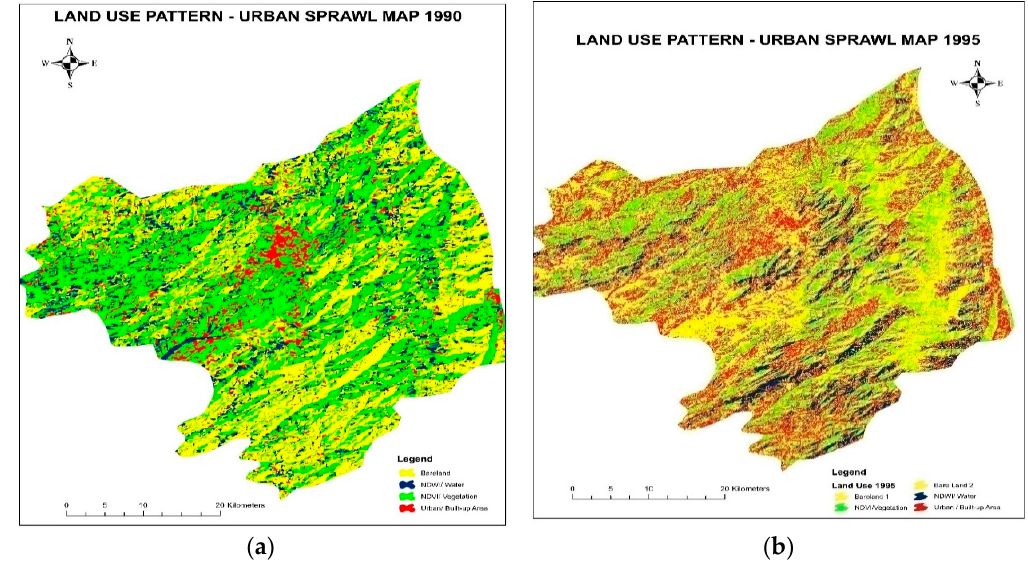
Figure 3. ( a ) Land use pattern of urban sprawl 1990; ( b ) land use pattern of urban sprawl 1995.